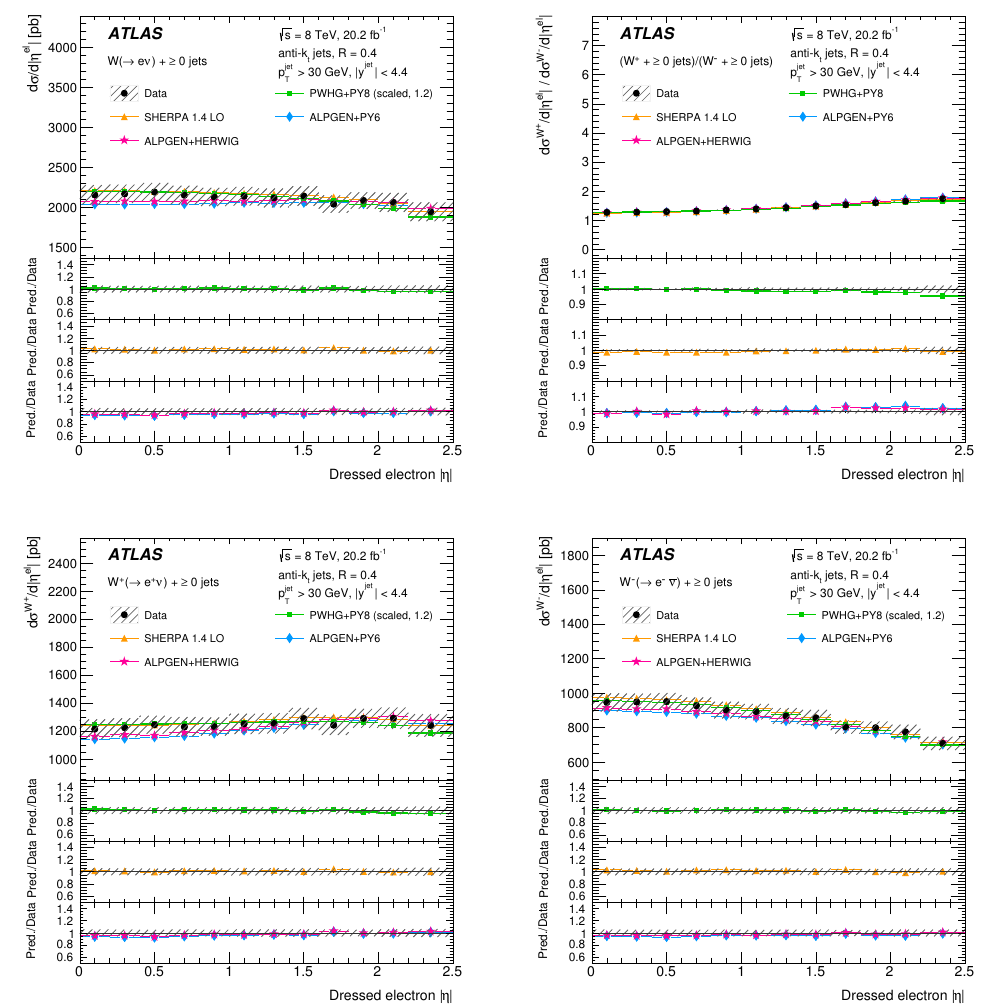
Figure 14 . Di(cid:11)erential cross sections for the production of W bosons (top left), W + (bottom left), W (cid:0) (bottom right) and the W + =W (cid:0) ratio (top right) as a function of the electron (cid:17) for events with N jets (cid:21) 0. For the data, the statistical uncertainties are indicated as vertical bars, and the combined statistical and systematic uncertainties are shown by the hatched bands. The uppermost panel in each plot shows the di(cid:11)erential cross sections, while the lower panels show the ratios of the predictions to the data. The theoretical uncertainties on the predictions are described in the text. The arrows on the lower panels indicate points that are outside the displayed range.